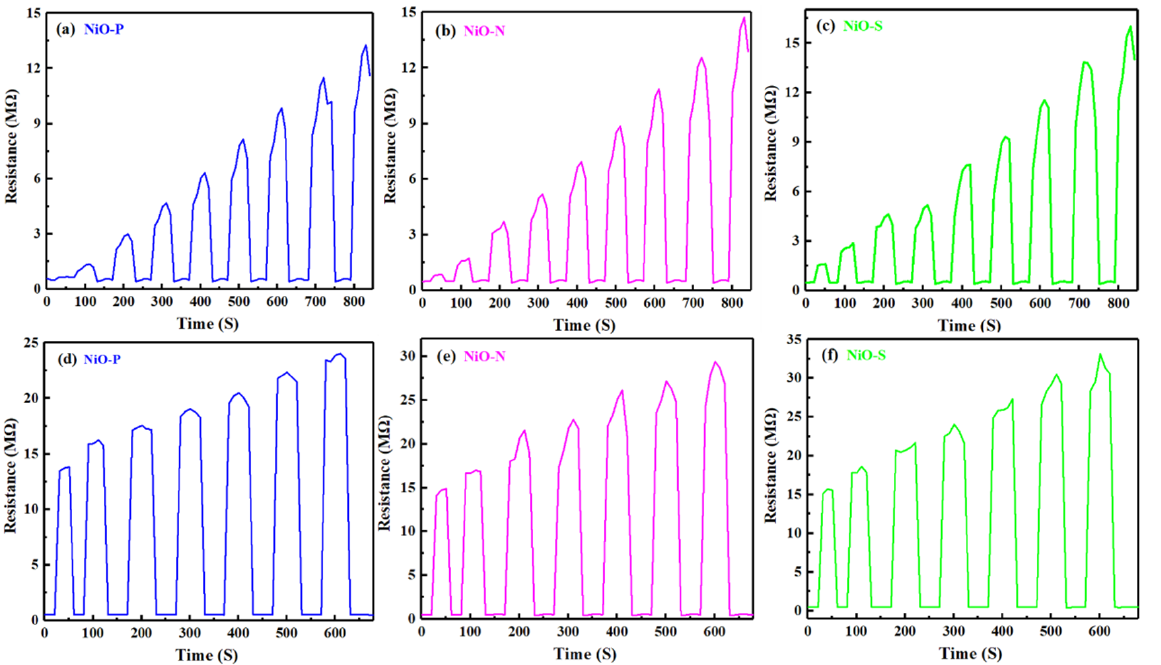
Figure 10. Dynamic response curves of NiO-P, NiO-N, and NiO-S in the range of ethanol concen- tration from ( a – c ) 10 to 90 ppm; ( d – f ) 100 to 700 ppm.